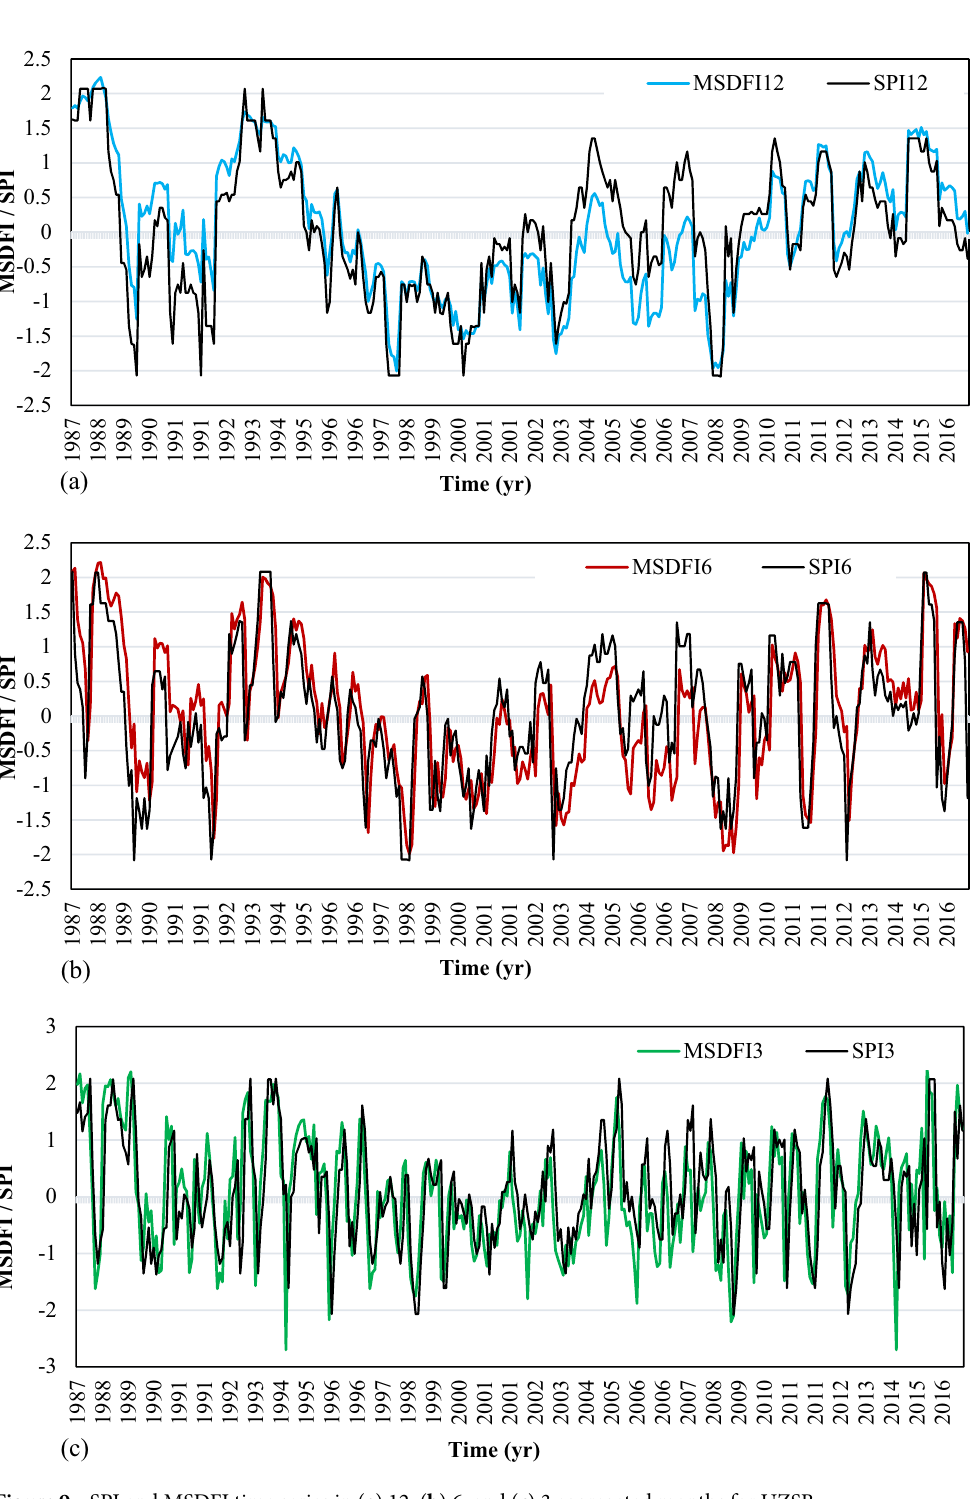
Figure 9. SPI and MSDFI time series in ( a ) 12, ( b ) 6, and ( c ) 3 aggregated months for